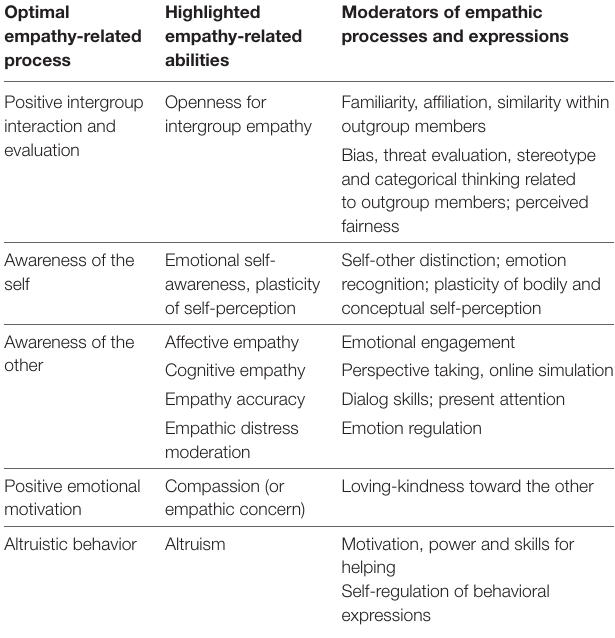
Moderators of empathic processes and expressions